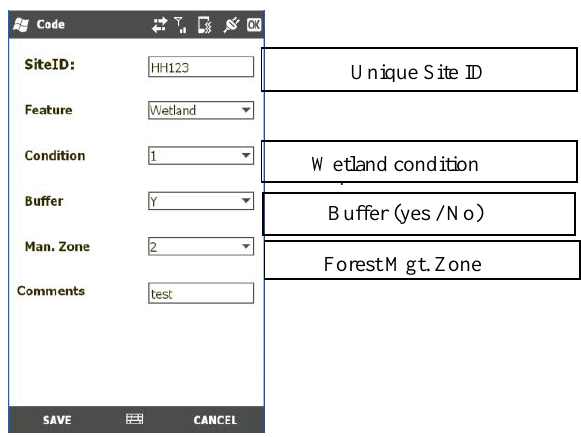
Figure 8. Display of images